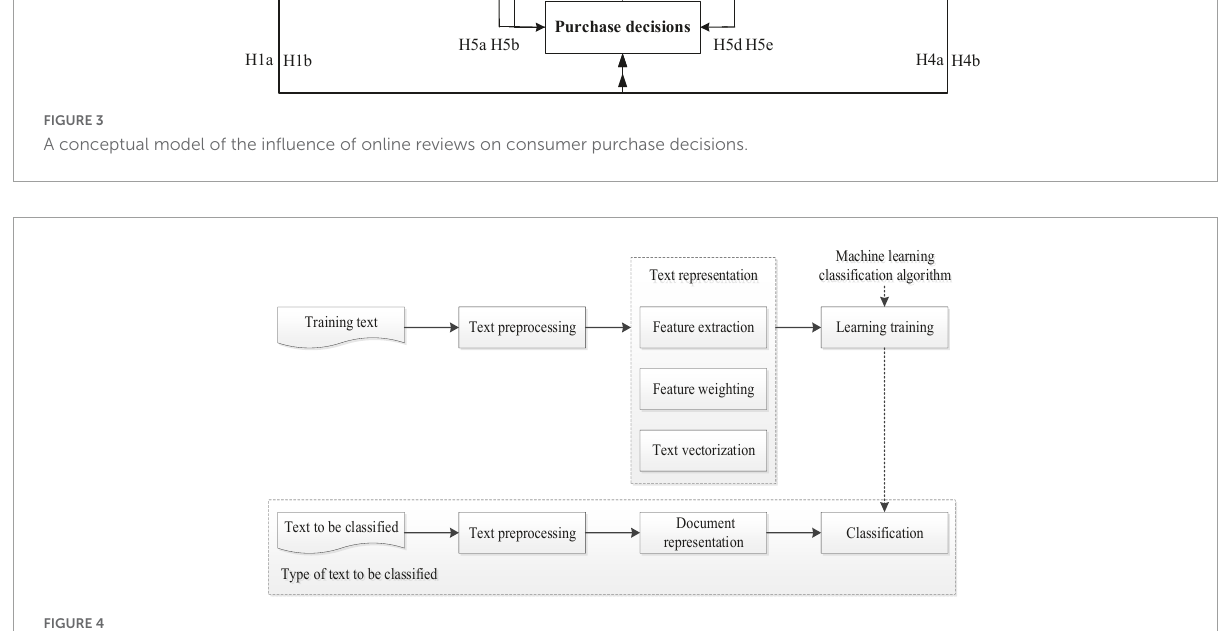
of new PCs (Nochai and Nochai, 2011).